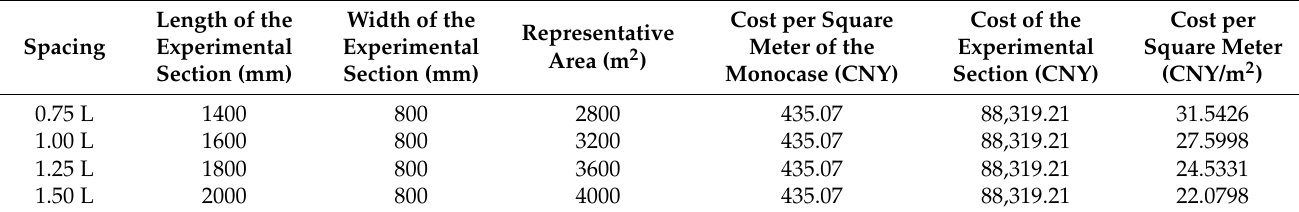
Table 3. Economic cost evaluation index of flow field effect of M-shaped unit